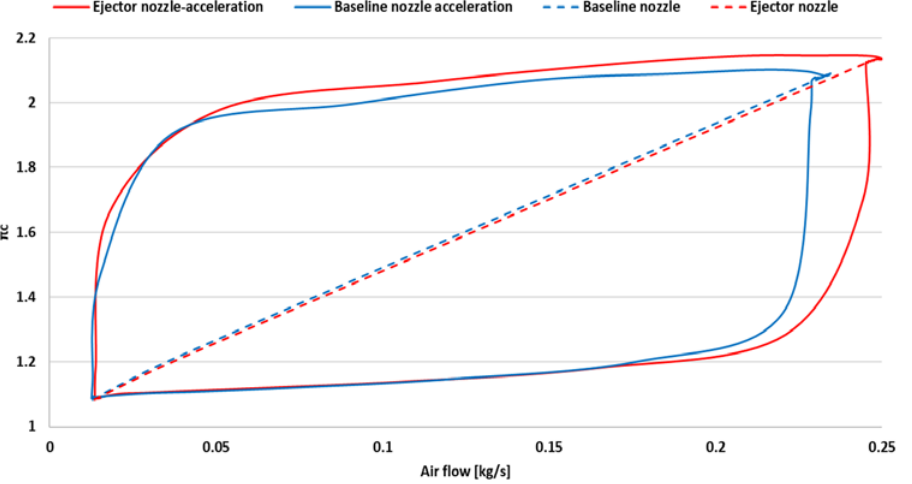
Figure 21. Variation of the operating line of the engine during sudden acceleration and deceleration.